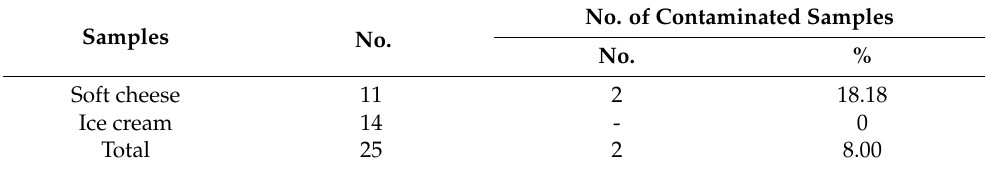
Table 2. Listeria monocytogenes recovered from the examined soft cheese and ice cream samples.